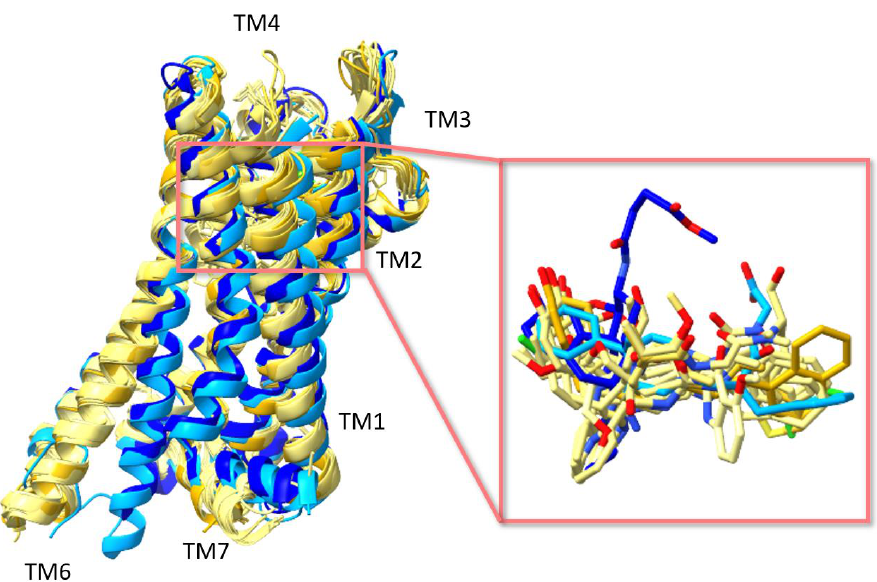
Figure 3. Alignment of eight MOR structures: the two MOR structures in a complex with an antagonist are in different shades of blue and six MOR structures in a complex with an agonist are in different shades of yellow. The right panel is an enlarged illustration of all ligands (both agonist and antagonist) aligned. This figure was generated with ChimeraX 1.4. [44,45].